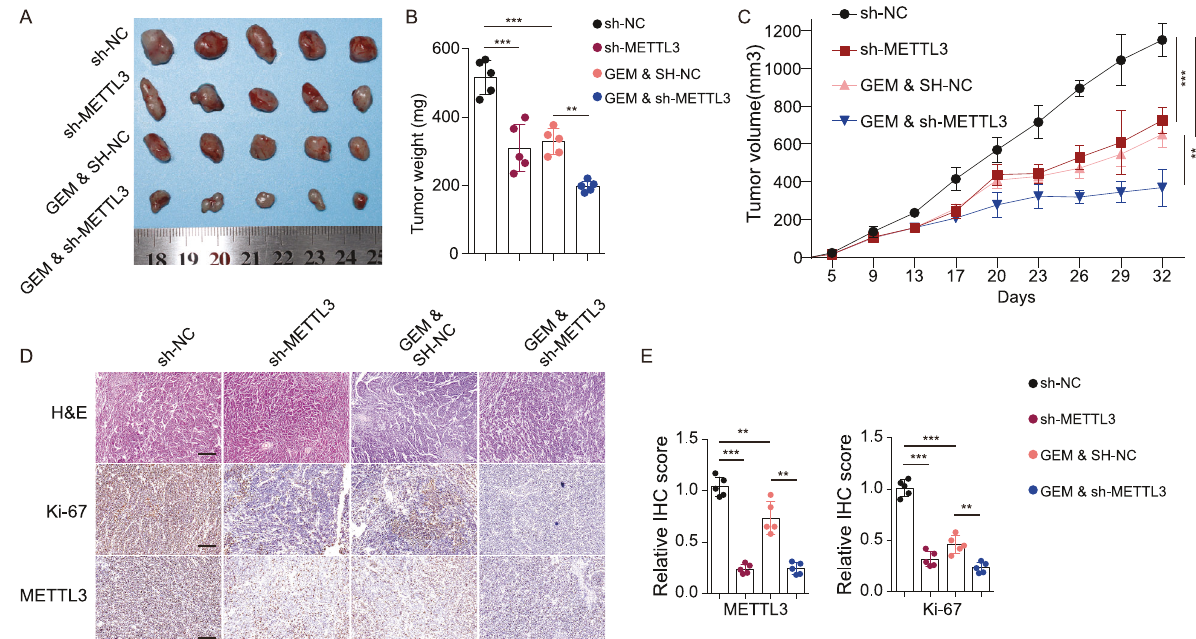
Fig. 2 METTL3 knockdown suppressed in vivo tumor growth in synergy with gemcitabine treatment. A A photograph of tumors from xenograft mice models with different treatments. B , C The weight ( B ) and volume ( C ) of tumors of xenograft mice models in the four groups. D Representative H&E, Ki67 IHC, and METTL3 IHC results of tumor tissues of xenograft mice models. E The statistical analyses of METTL3 and Ki67 IHC results. sh-NC sh-METTL3 negative control, GEM gemcitabine treatment. For B , C , E ** P < 0.01, *** P < 0.001, compared with the sh-NC